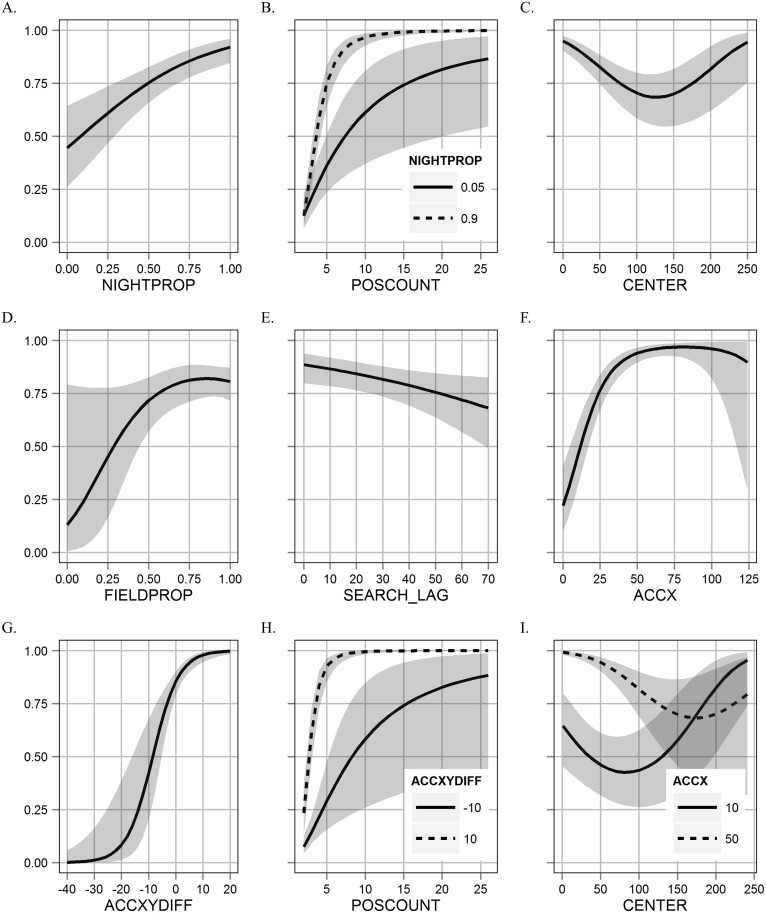
Feeding Event Probability Response Plots.Response plots for the predicted probability (y-axis) of a cluster being a feeding event and 95% CI (gray shading) for each individual covariate while holding all other covariates at their mean observed values. Parameter space for each covariate value (x-axis) is given for a realistic range of values. Various combinations with other variables (interaction or additive effect), discretized to factor values are given in plots with both solid and dashed lines.